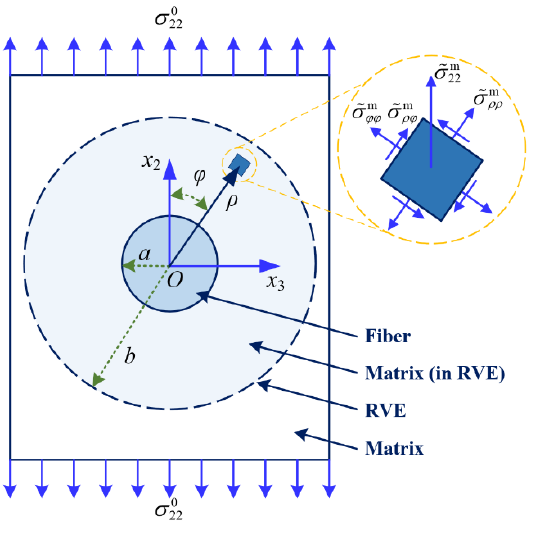
Figure 1. Illustration of the CCA model under transverse